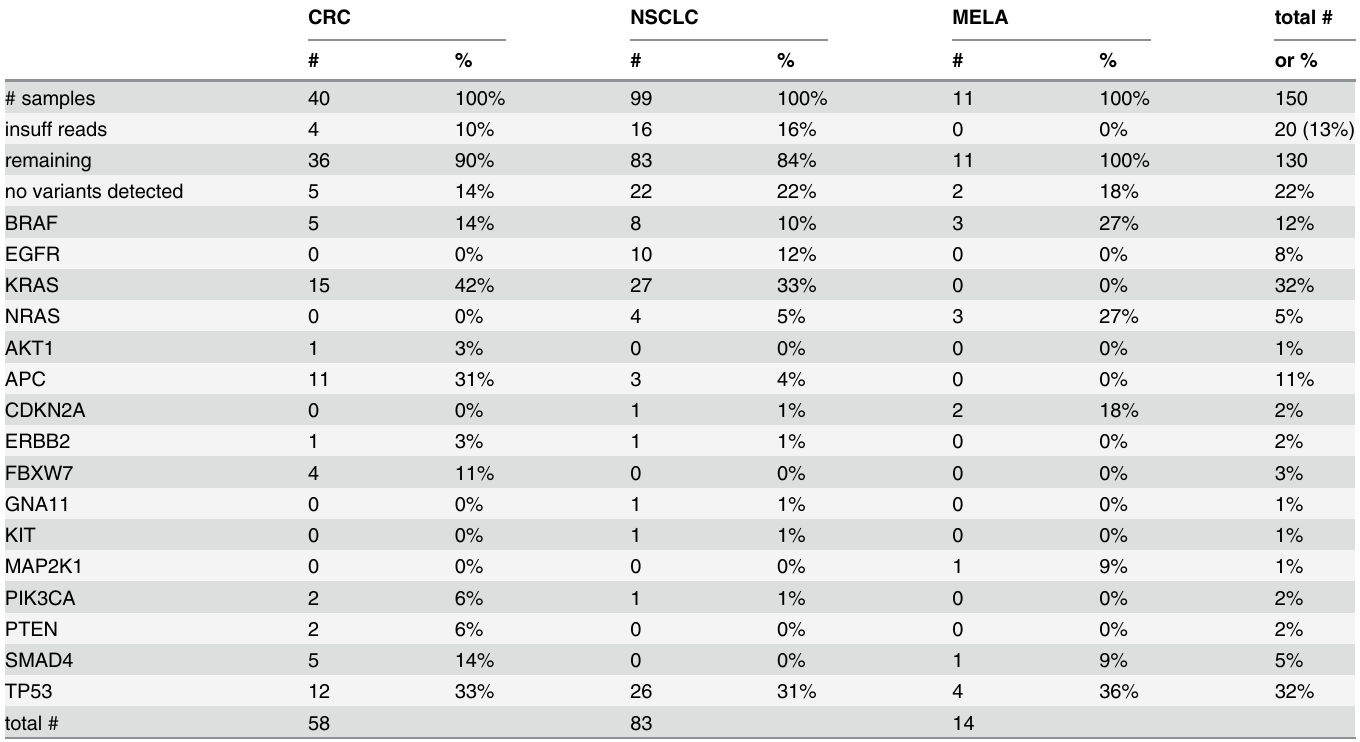
Table 2. Targeted NGS analysis on 150 diagnostic FFPE samples. Number (#) and percentages (%) of samples and variants are indicated for the three tumor types investigated. Only pathogenic or presumed pathogenic variants that met the acceptance criteria (Cov > 300; VAF > 5%) were included.